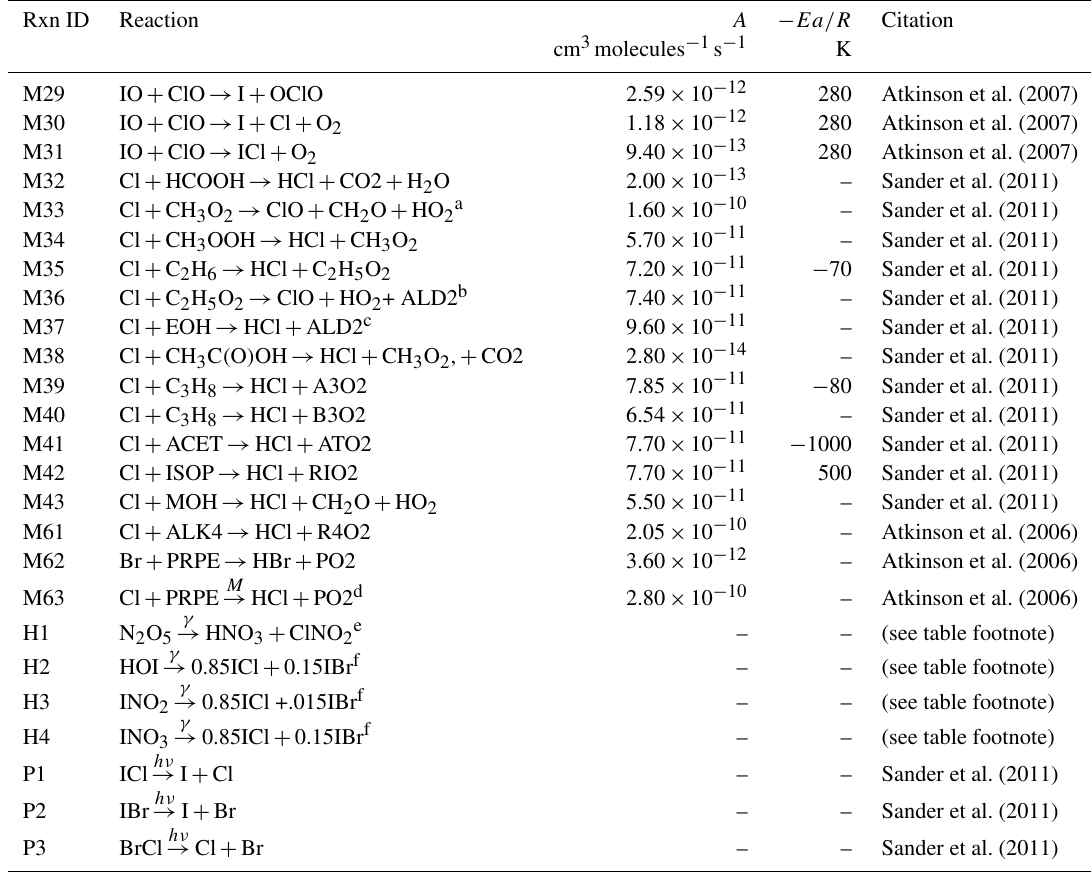
Table 1. Additional halogen reactions included in this simulation that are not described in previous work (Eastham et al., 2014; Schmidt et al., 2016; Sherwen et al., 2016a). The full reaction scheme is given in Appendix B (Tables B2–B5). The rate constant is calculated using a ) . standard Arrhenius expression A · exp ( − Ea RT